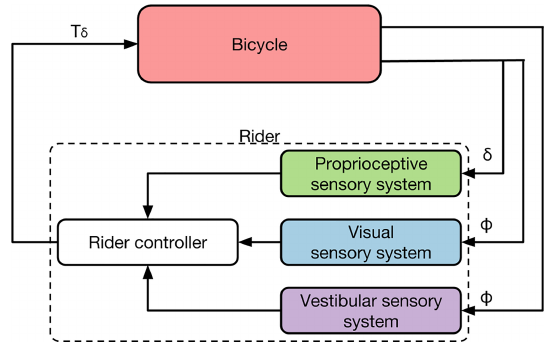
Figure 1. Block diagram of the bicycle-rider system illustrating the relation between the primary sensory systems and bicycle states [ φ,δ ] the rider uses to control the bicycle by applying a steer torque T δ